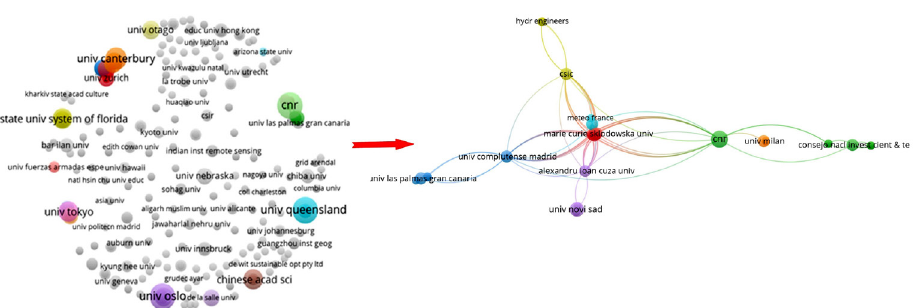
Figure 5. Institution collaboration network and maximum subnetwork